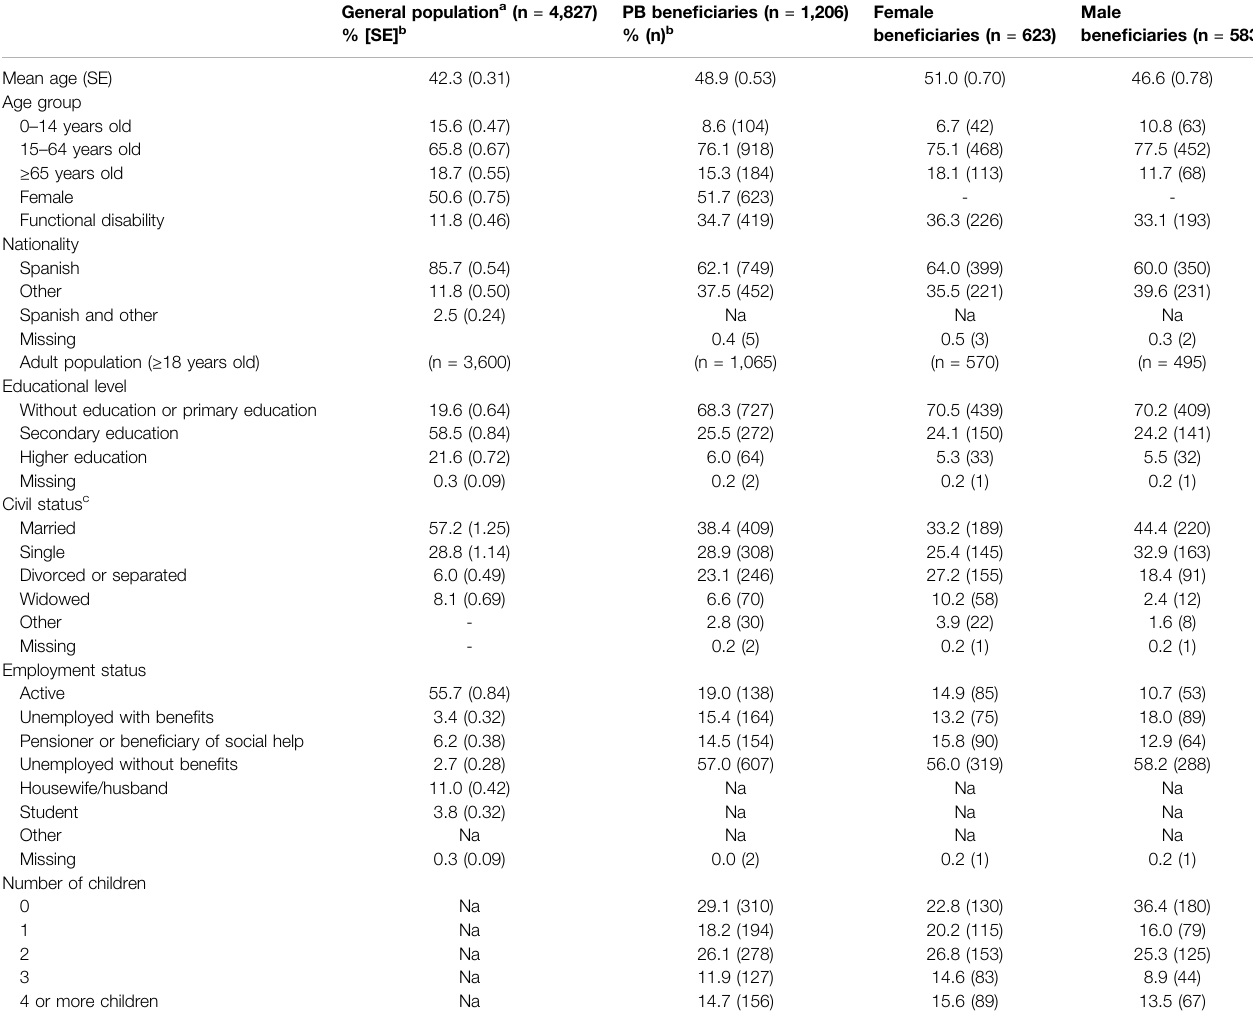
TABLE 1 | Sociodemographic characteristics of the